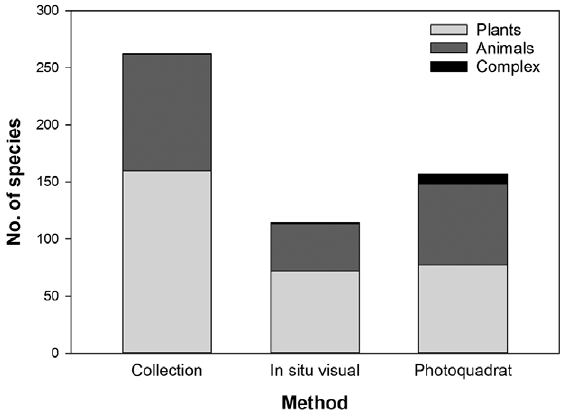
Fig. 1. – Total number of species identified with each method. The term “complex” stands for a turf of intermingled filamentous algae and invertebrates (mainly hydrozoans and